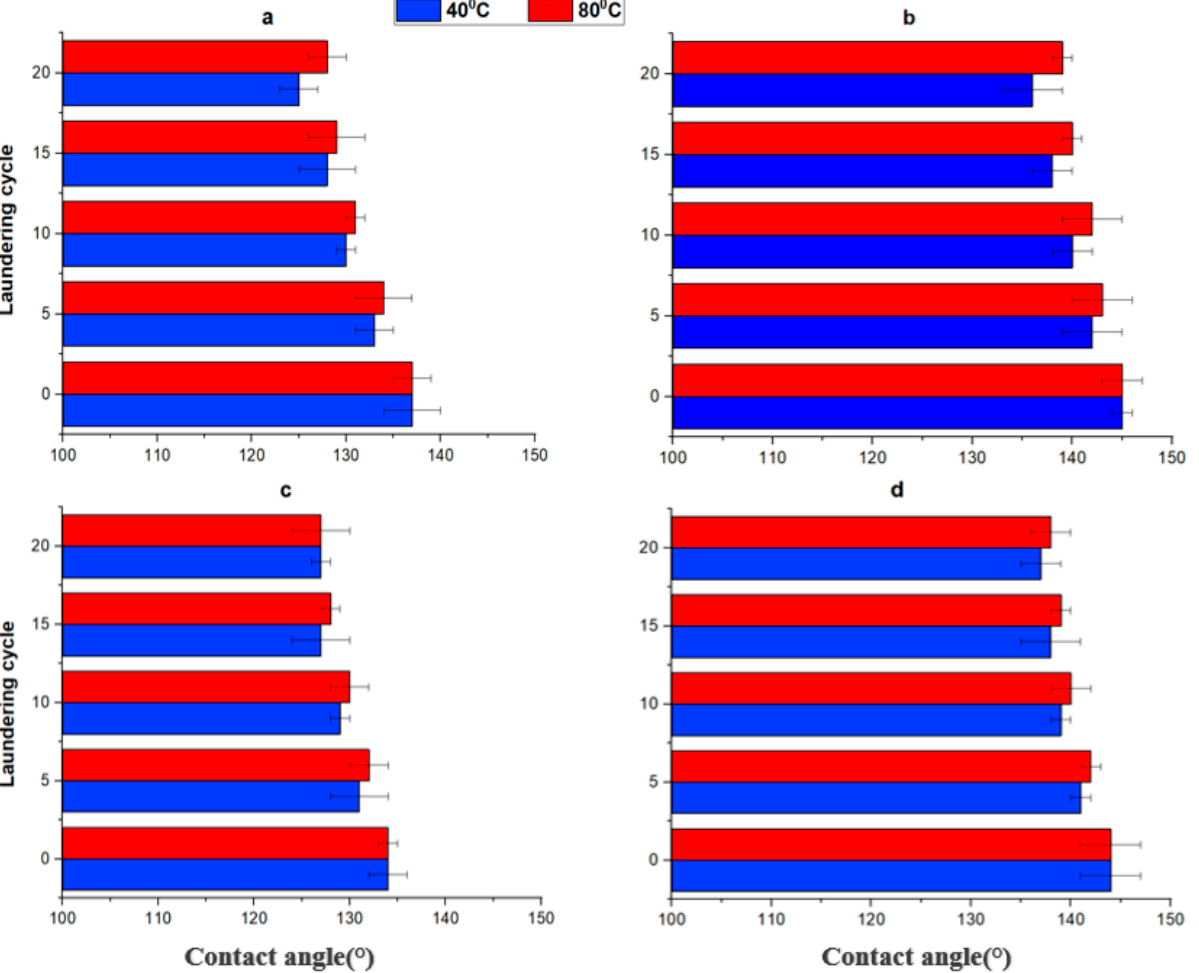
Figure 6. Variation of WCA of ( a ) Si-Cot_Dip and ( b ) Si-Cot_Dip/O 2 ( c ) Si-Cot_Plasma ( d ) Si- Cot_Plasma/O 2 after laundering tests at different temperatures.